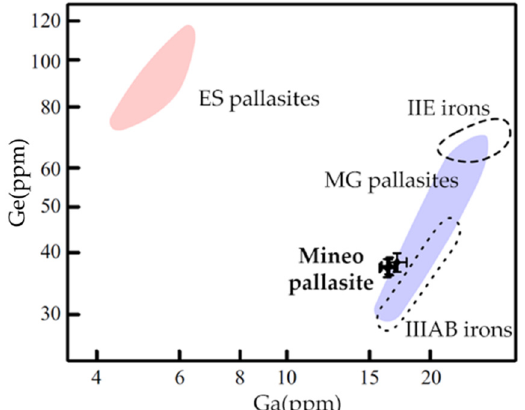
Figure 3. Logarithmic Ga-Ge plot where Eagle Station (ES, red) and Main Group (MG, blue) pallasite fields are shown together with meteorite fields of IIIAB irons (dotted line) and IIE irons (segmented line). The Mineo data are in black (after Scott 1977 [47]). The picture is modified from Zucchini et al. (2018) [41]. (Color figure can be viewed at wileyonlinelibrary.com).